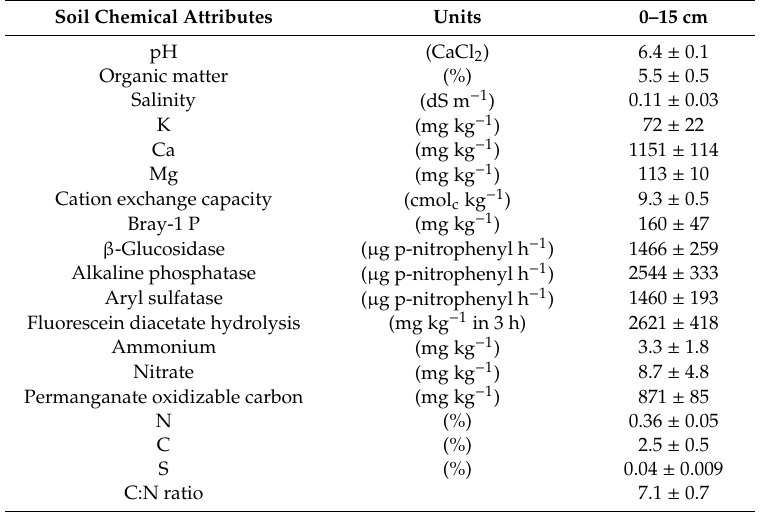
Table 2. Soil chemical attributes in 0–15 cm layer before the field trial at Pennsylvania